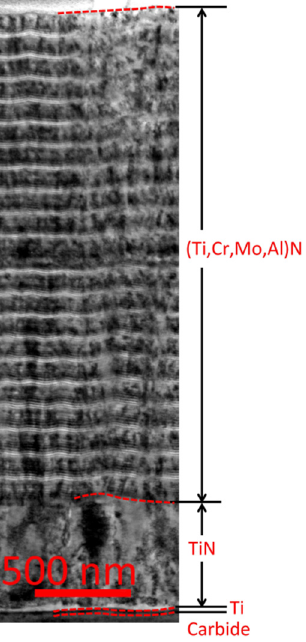
Figure 1. General structure of the Ti-TiN-(Ti,Cr,Mo,Al)N coating (TEM).